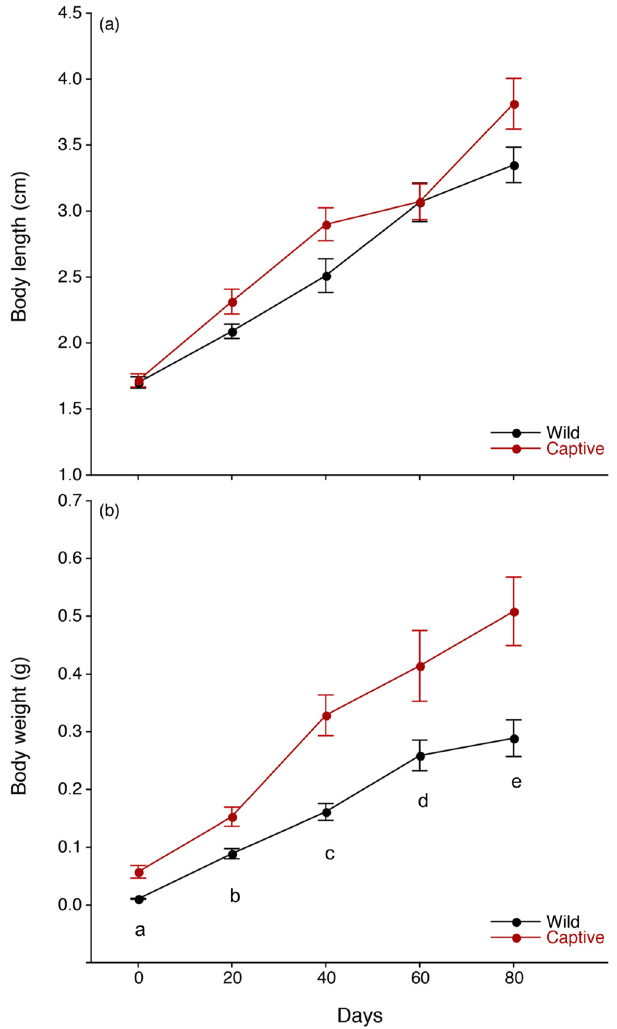
Figure 2: Growth patterns of body length ( a ) and body weight ( b ) in wild ( black line ) and captive ( red line ) postlarvae in the giant freshwater prawn Macrobrachium rosenbergii . The results are expressed as the mean ± standard error ( SE ) . The letters ( a – e ) indicate a statistically signi fi cant di ff erence at p < 0.05 between wild and captive